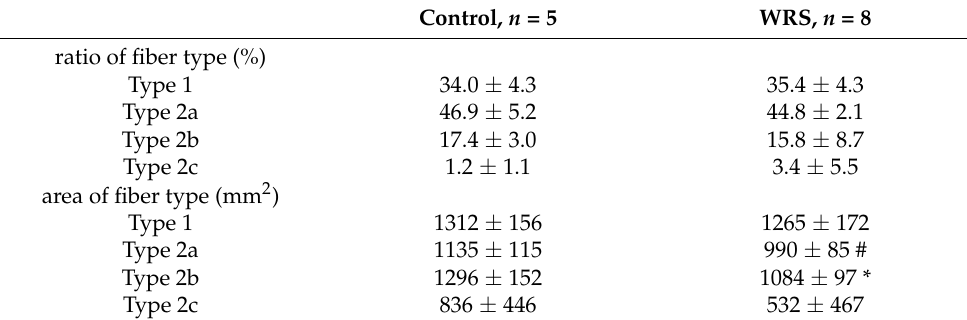
Table 4. Muscle fiber typing and cross-sectional area of soleus.